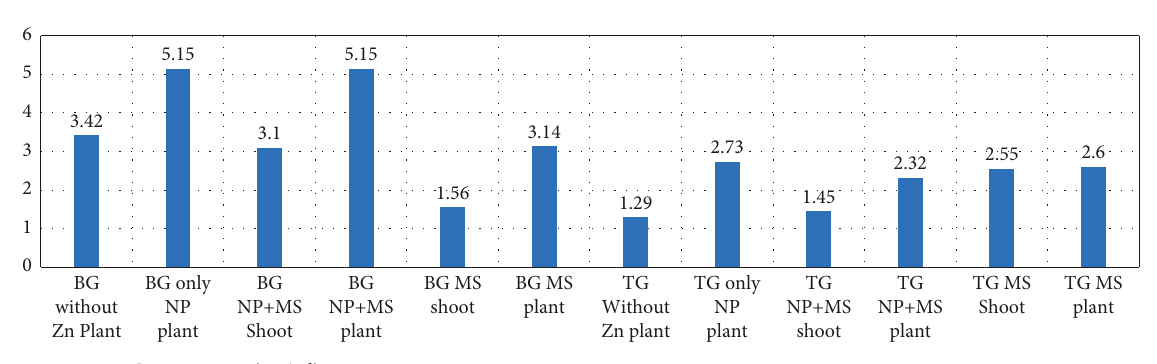
Figure 6: Protein estimation after 7 days, the 1st set. BG: Bengal gram, TG: Turkish gram, and GG: green